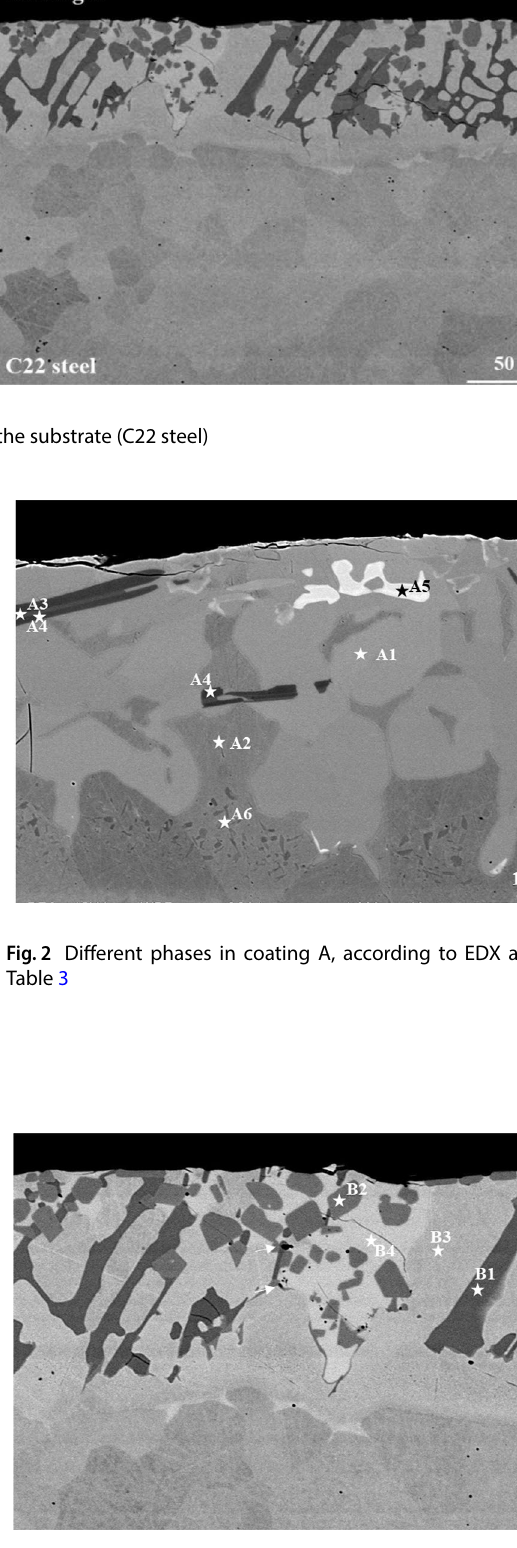
Fig. 3 Different phases in coating B, according to EDS analysis in Table